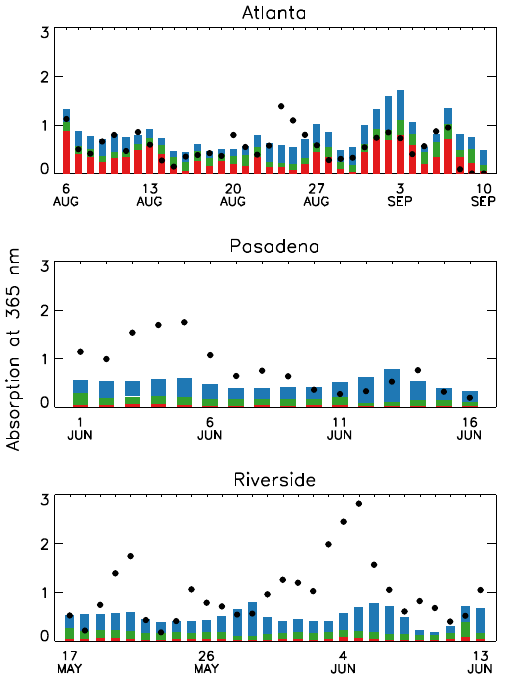
Figure 4. Simulated versus observed daily mean light absorption at 365nm by water-soluble BrC over the United States in 2010; unit is Mm − 1 . Black circles denote observations and bar graphs indi- cate model results for each source – biomass burning (red), bio- fuel (green), and SOC